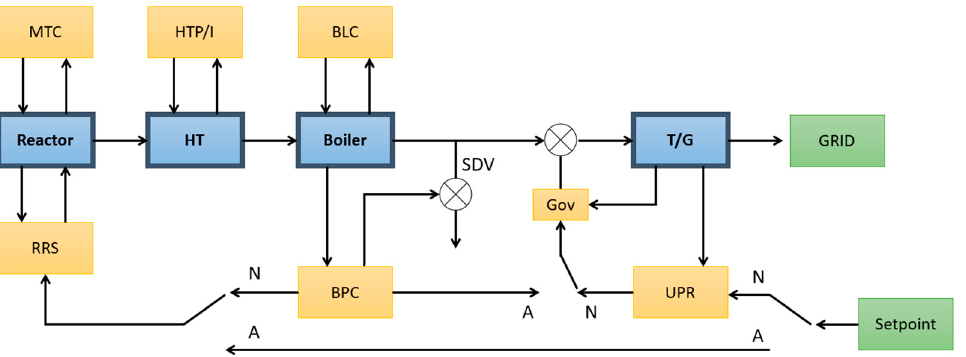
Figure 2. Modes of an NPP’s operation. Basically, there are two modes of operation in a nuclear power plant, namely, the normal and alternate modes. Their selection will depend on the actual scenario and the necessity of adjusting the output power. When a variation in the electrical demand occurs, the mismatch will provoke a frequency variation in the electrical grid. This fluctuation